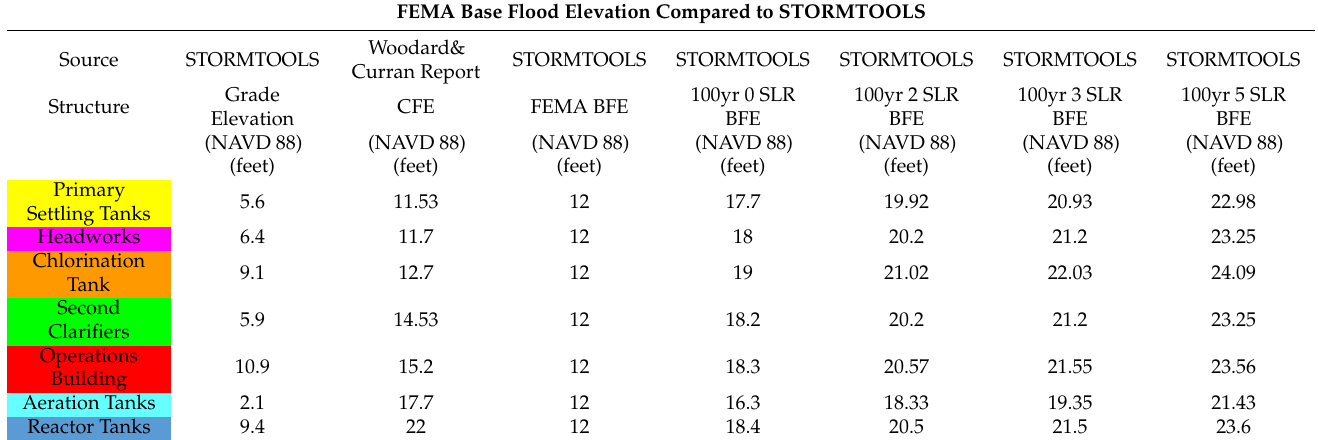
Table 1. Grade elevation, CFE, FEMA BFE, and STORMTOOLS BFE (0, 2, 3, and 5 ft SLR) for each component of the Warren, RI WWTF. Color coding for components is consistent with Figure